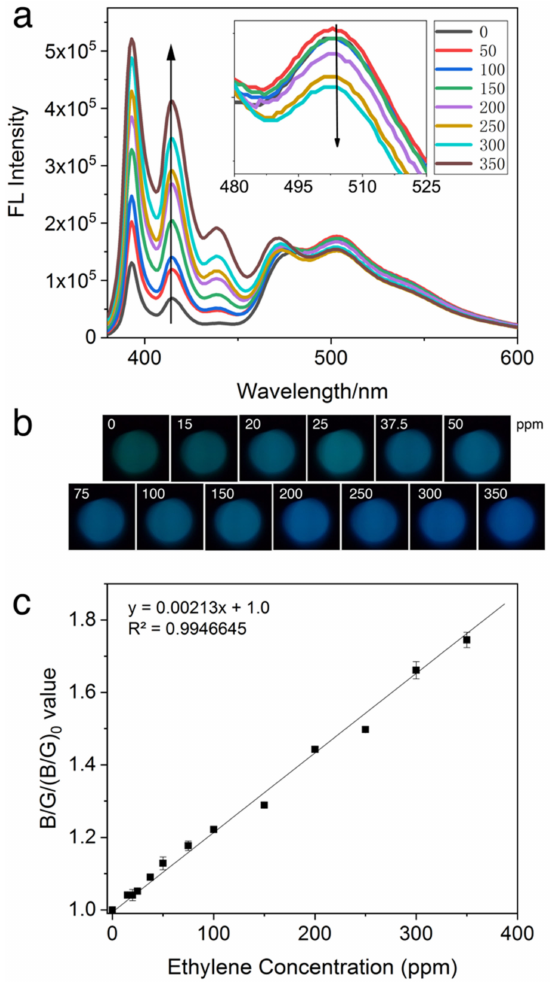
Figure 4. ( a ) Emission spectra of the PYG probe at 30 µ M in CH 2 Cl 2 exposed to 0–350 ppm ethylene, ( b ) the visual color changes of PYG corresponding to different concentrations of ethylene, and ( c ) plots of ( B/G )/( B/G ) 0 value versus different concentrations of ethylene. Where ( B/G ) 0 and ( B/G ) represent the RGB values extracted from CMOS sensor ( λ ex = 365 nm) of blank and after the addition of ethylene, respectively. The number of data points for the single determination is